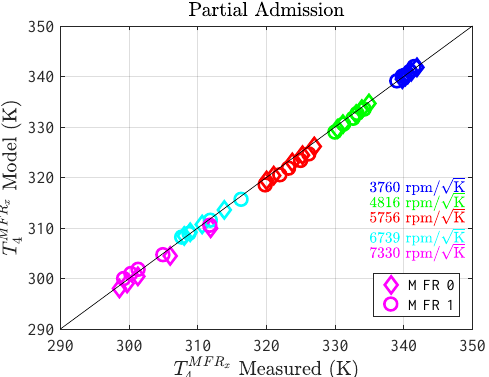
Figure 19. Estimated turbine outlet temperature using extrapolated maps of MFR 0 and 1 for